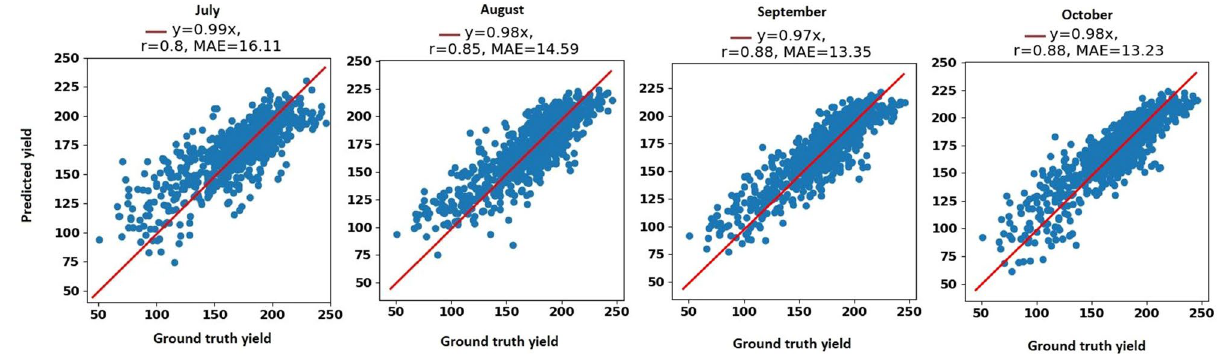
Figure 7. The scatter plots for the 2018 corn yield prediction during the growing season in the months July, August, September, and October. MAE and r stand for mean absolute error and correlation coefficient, respectively. The unit of yield is bushels per